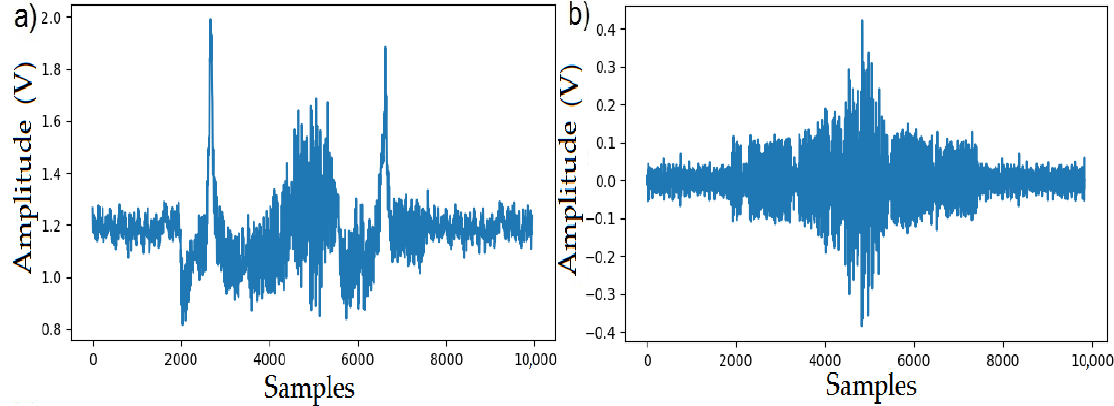
Figure 13. EMG signal: ( a ) Unfiltered signal, ( b ) filtered signal.